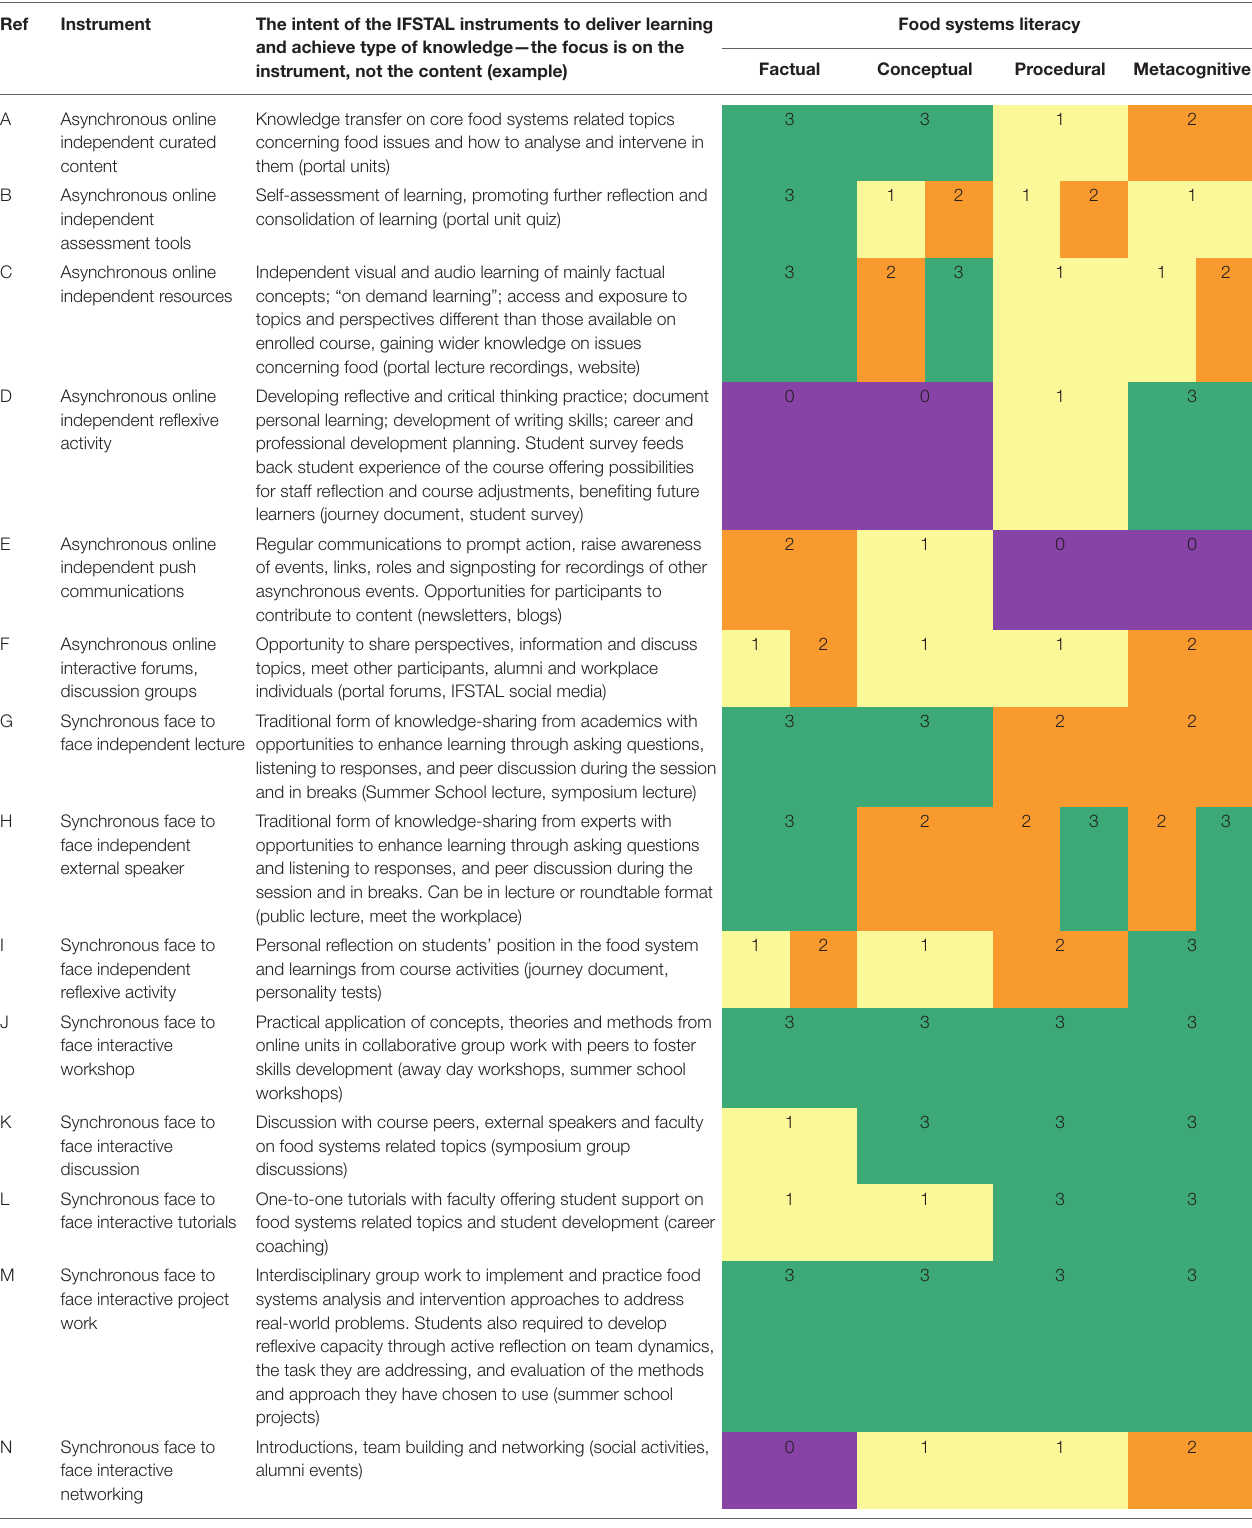
TABLE 3 | IFSTAL teaching instruments and their contribution to food systems